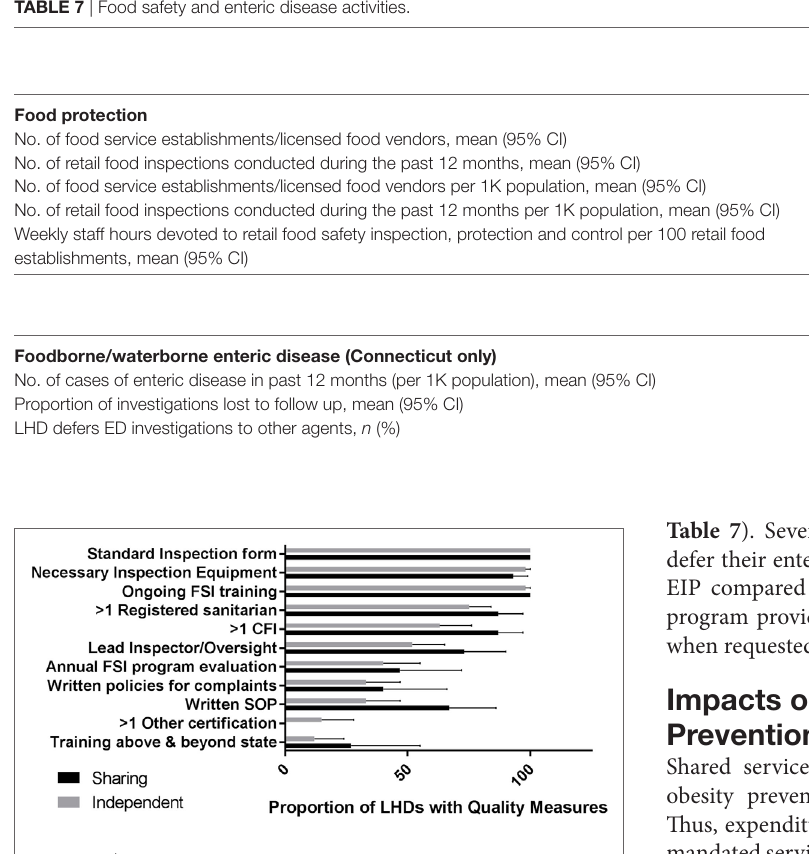
FigUre 2 | Proportion of local health departments with each food safety inspection (FSI) quality indicator. Quality indicators include (1) availability of certified FSI personnel, (2) ongoing FSI training, (3) on going FSI training that is above and beyond state requirements, (4) availability of a standard inspection reporting form, (5) written standard operating procedures, (6) presence of formal program oversight, (7) availability of written policies for complaints, (8) availability of necessary inspection equipment, and (9) an annual FSI program evaluation.